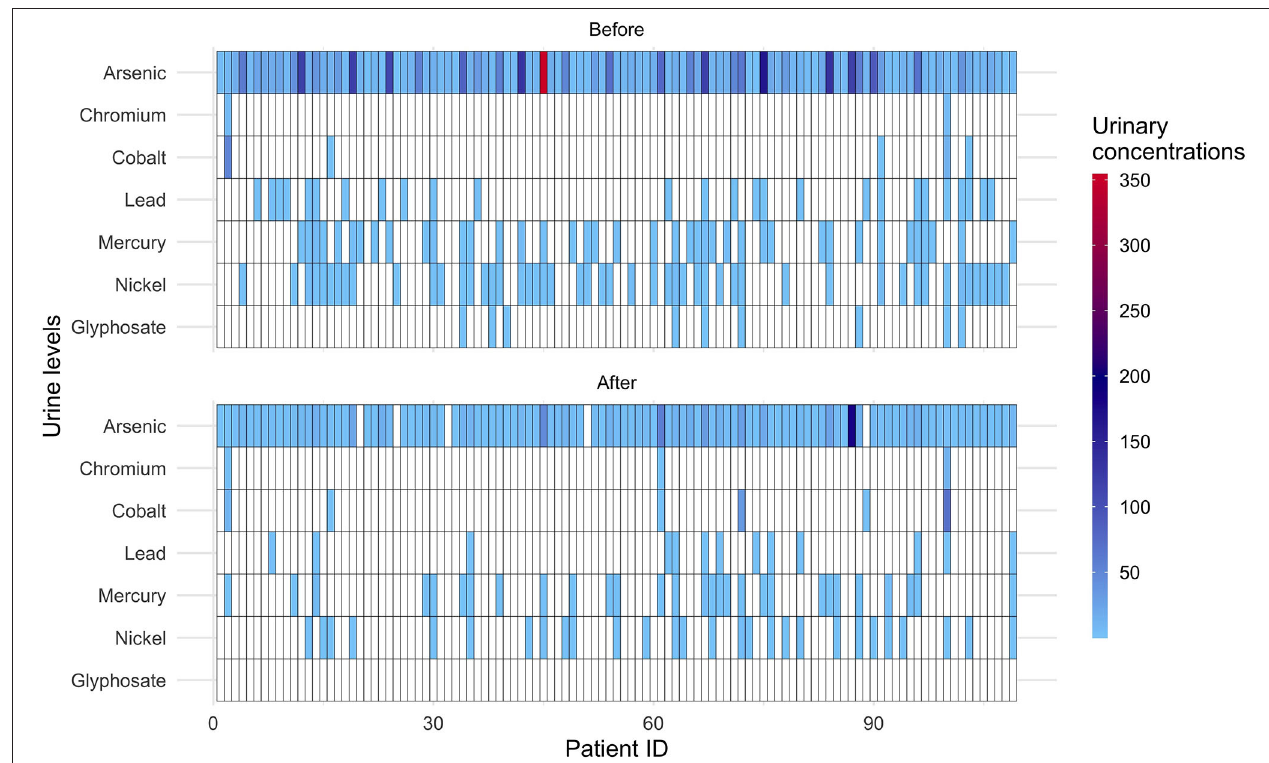
FIGURE 2 | Heatmap displaying the individual excretion of heavy metals and glyphosate before and after 10-days fasting. The color scale shows the urinary levels ( µ g/l) of heavy metals and glyphosate. Data below detectable levels are indicated in white. Patient ID: individual identification numbers (in total 109).